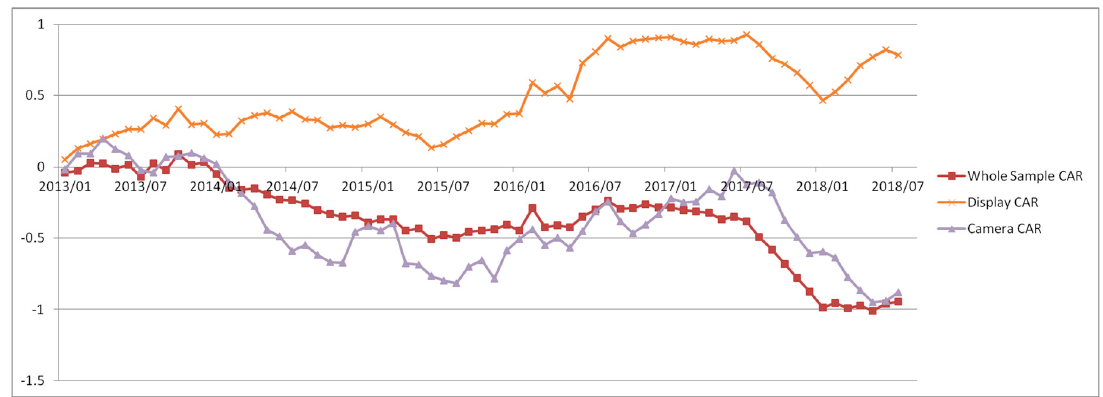
Figure 9. Average CAR for Evaluation period: 2010-2011, Event period: Jan 2013–Jul 2018. Table 4. Cross-correlation of average CARs for Evaluation period: Jan 2010-Dec 2011, Event period: Jan 2013–Jul 2018.